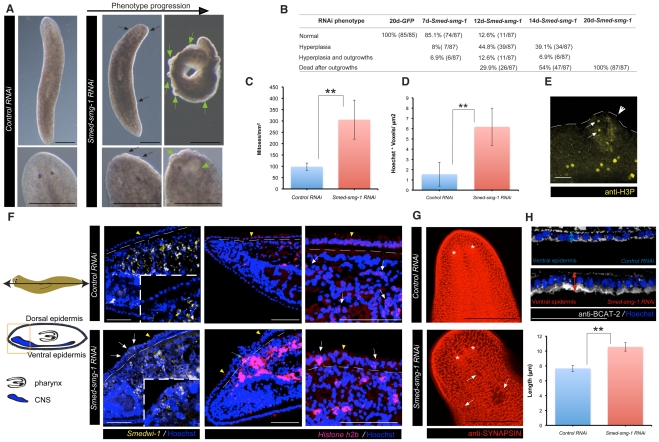

Smed-smg-1(RNAi) leads to lethal outgrowths during planarian homeostasis.A, B. Panels and table show Smed-smg-1(RNAi) phenotype progression compared to controls. Black arrows show epidermal hyperplasia and green arrows show outgrowths. B. Progression of the RNAi phenotypic characteristics at various time points (days) after the last injection. C. Mitotic numbers at 9 days after the last injection (n≥6 per condition). D. Volume of nuclei in 10 µm paraffin sections. Equivalent regions for at least 6 different planarians per condition were measured. E. Single confocal section of H3P+ cells (arrows) observed in an outgrowth (arrow head) for a Smed-smg-1(RNAi) animal at 9 days after the last injection (n = 7/8 displaying outgrowths had mitotic cells visible; see Video S3 for a whole worm view). F. The cartoons show how the sagittal paraffin sections were performed. Panels display the region of the orange square in the cartoons. Panels are maximum confocal projections of slices performed on 10 µm paraffin sections showing a monostratified dorsal and ventral epidermis in control animals and a multistratified dorsal epidermis in the case of Smed-smg-1 (RNAi) animals (yellow arrowheads). Smed-smg-1(RNAi) animals show Smedwi-1
+ cells in outgrowths (white arrows; n = 2/4 planarians), h2b
+ cells infiltrating to the epidermis (green arrow) and disrupting the integrity of the basement membrane (dotted white line) and at the multilayered epidermis (white arrows; n = 3/4 planarians). G. Dorsal-most confocal sections of the planarian head showing the subepidermal nerve plexus stained by synapsin where several disruptions can be observed in Smed-smg-1(RNAi) animals (arrows). Asterisks indicate the position of the eyes. H. The panels and graph show that Smed-smg-1(RNAi) animals have bigger ventral epidermal cells (hypertrophy) than controls. Panels display the ventral epidermis (deconvolved confocal maximum projections of slices performed on 10 µm paraffin sections). Double arrows show the distance from the basement membrane until the outer membrane of the epidermal cells (stained with anti-BCAT-2). See Material and methods for details about quantification method. Error bars for all the graphs are s.d from the mean and asterisks indicate P<0.01 using two-tailed Student's test with equal sample variance. Black scale bars indicate 300 µm and white scale bars indicate 50 µm.